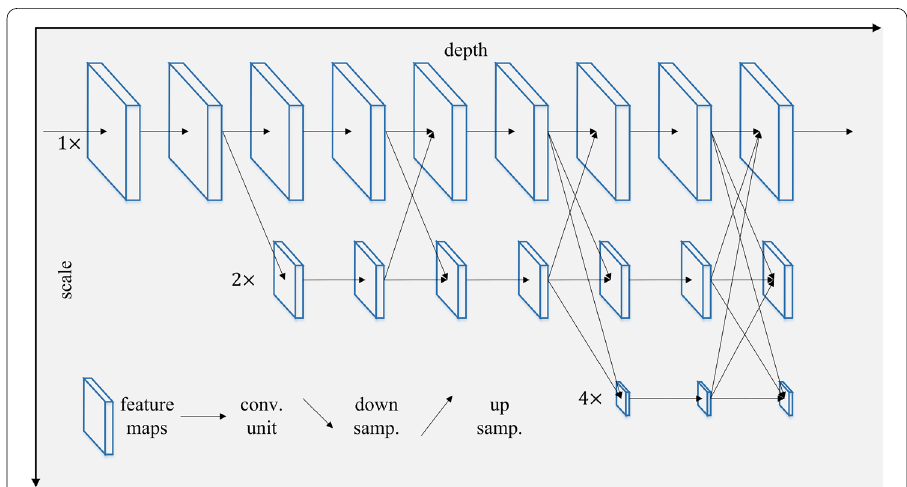
Fig. 1 Architecture of the HRNet. The architecture of the HRNet. It consists of parallel high-resolution and low-resolution subnetworks with repeated information exchange between multiresolution subnetworks (multiscale